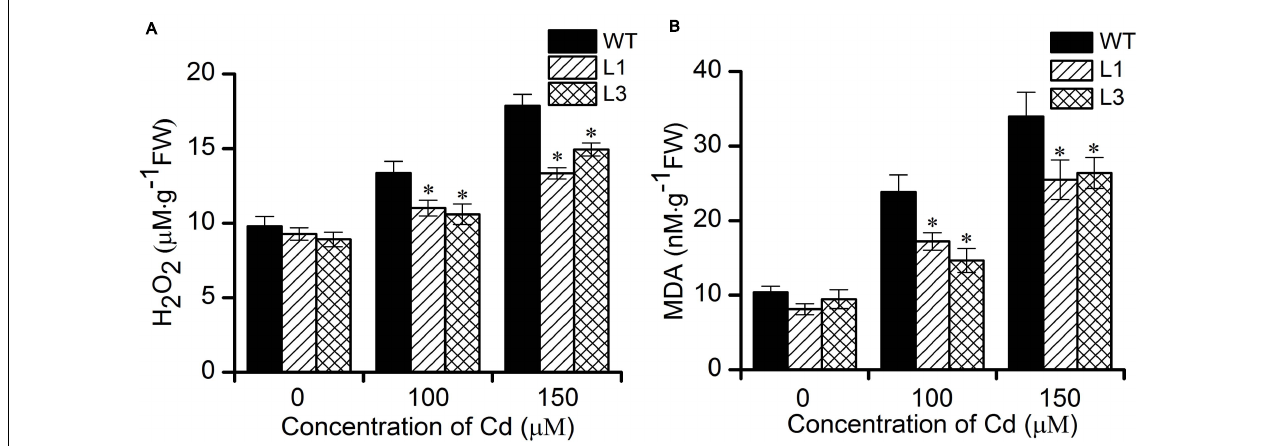
FIGURE 5 | Cellular H 2 O 2 and MDA contents in WT and BnPCS1 -expressing transgenic Arabidopsis plantsin response to Cd stress. (A) H 2 O 2 contents in WT and transgenic line plants treated with 0, 100,and 150 µ M Cd for 2 days. (B) MDA contents in WT and transgenic line plants treated with 0, 100,and 150 µ M Cd for 14 days. Data are presented as the means of three biological replicates with SE shown by vertical bars. Asterisks indicate significant differences ( p < 0.05) in Cd-treated plants compared to